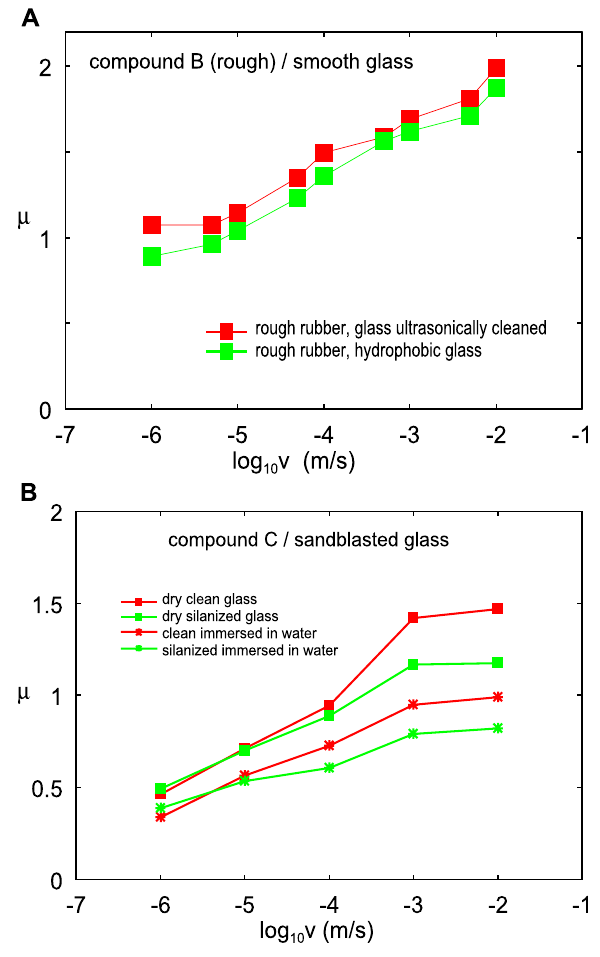
FIGURE 12 | (A) The friction coef fi cient as a function of the logarithm of the sliding speed for the compound B. The red squares are on a dry glass surface cleaned by acetone and isopropanol and then ultrasonic cleaned in distilledwater.Thegreensquaresareforahydrophobic(silanized)glass. The rubber block surface is roughened by sand paper. The nominal contact pressure p (cid:1) 0.06 MPa and the temperature T (cid:1) 20 ° C. (B) The friction coef fi cientasafunctionofthelogarithmoftheslidingspeedforthecompound Consandblastedglass.Theredsquaresareonadryglasssurfacecleanedby acetone and isopropanol and then ultrasonic cleaned in distilled water. The greensquares areforahydrophobic(silanized)glass. Thesquare symbols are for dry contact and the stars in water. The nominal contact pressure p (cid:1) 0.06 MPa and the temperature T (cid:1) 20 ° C.